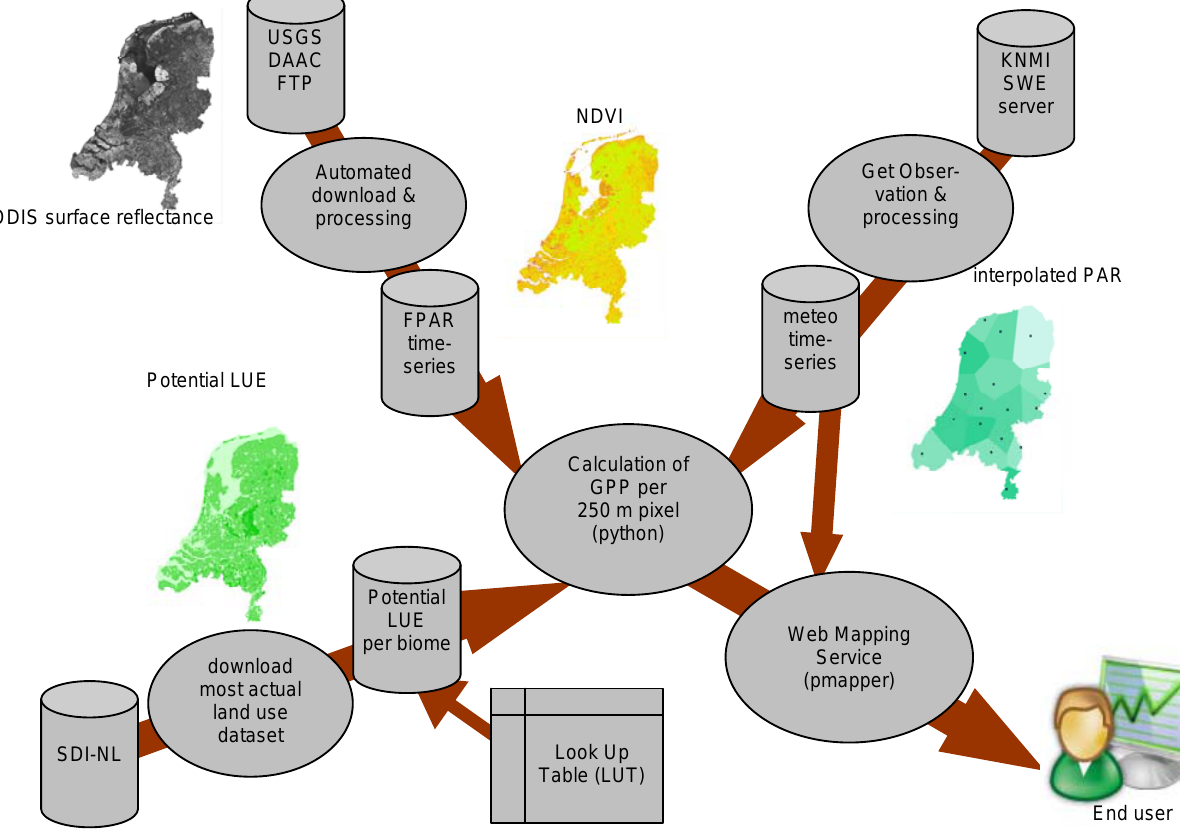
Figure 1 . Overview of different steps in the automated processing chain for the calculation of vegetation productivity over the Netherlands and the presentation of resulting maps for GPP in web mapping